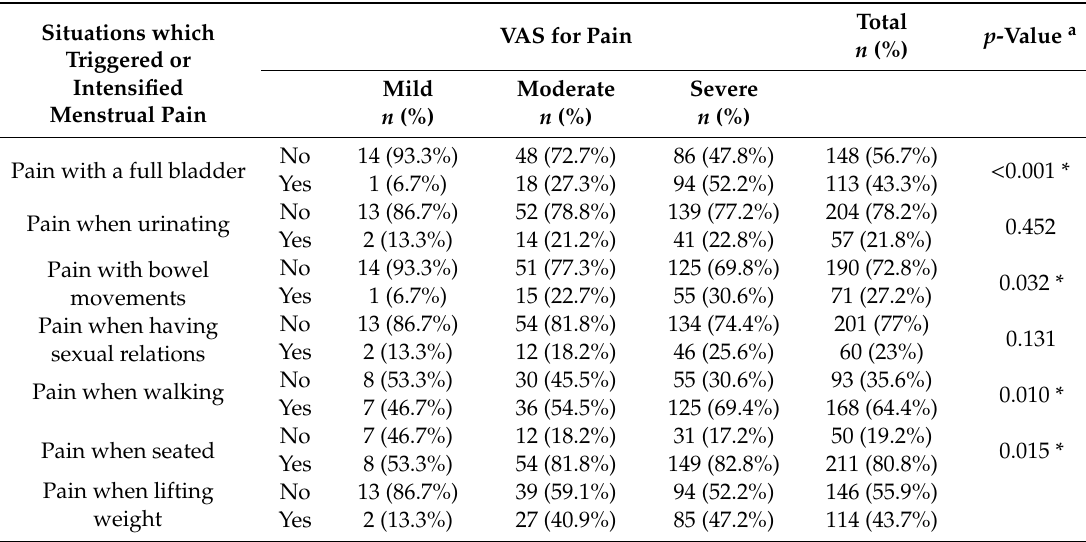
Table 2. Situations which triggered or intensified menstrual pain in students, categorized by pain intensity (VAS).